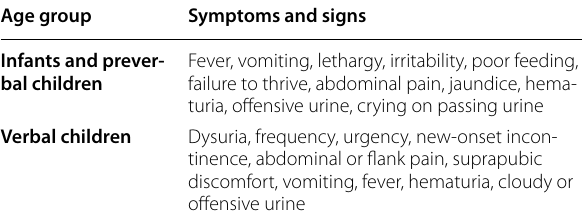
Table 5 Clinical features in relation to age Age